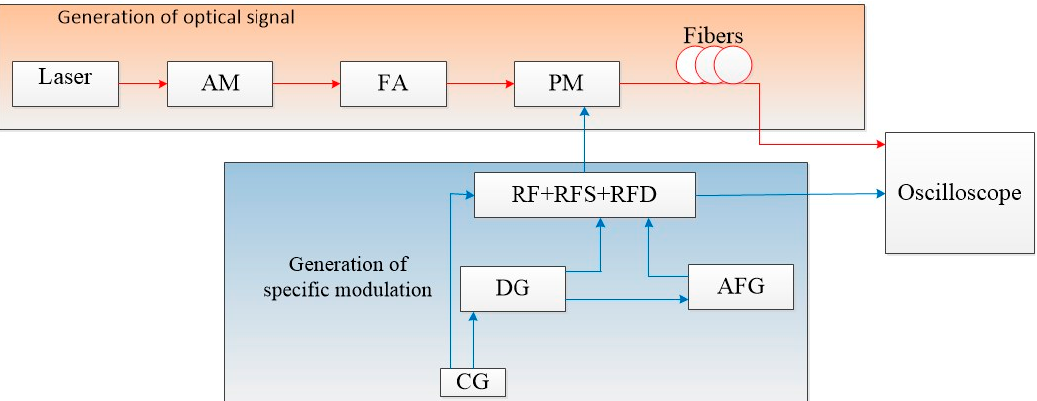
Figure 4. Structure of the proposed specific phase modulation system. PM: Phase modulator; RF: Radio frequency; RFS: Radio frequency switch; RFD: Radio frequency driver; DG: Delay generator; AFG: Arbitrary function generator; CG: Clock generator; FA: Fiber amplification; AM: Amplitude modulator. Firstly, we measure a specific modulation signal with a maximum spectral width of 0.5 nm and frequency of 19.75 GHz, which is shown in Figure 5.